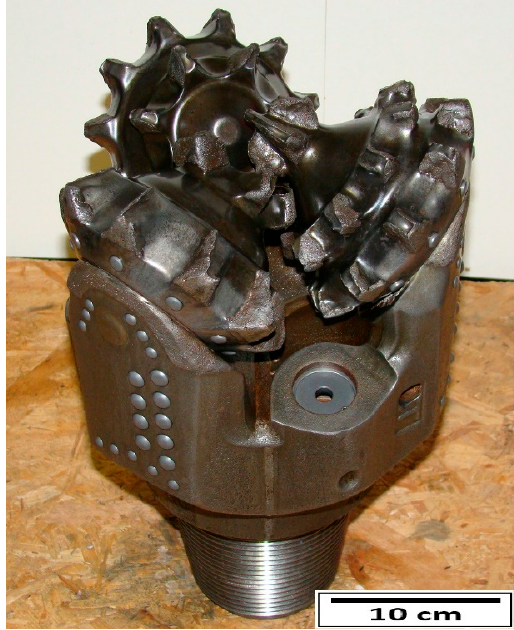
Figure 4. Worn roller cone drill bit ( ∅ 215.9 mm) after drilled interval.